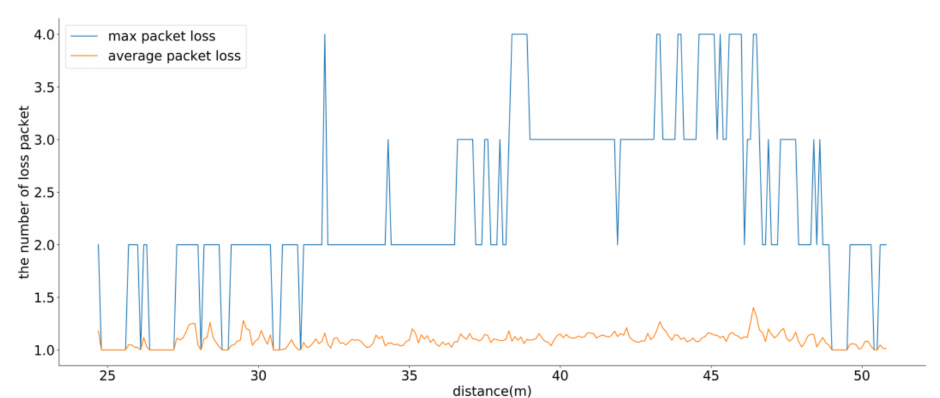
Figure 7. Results of the maximum and average burst packet